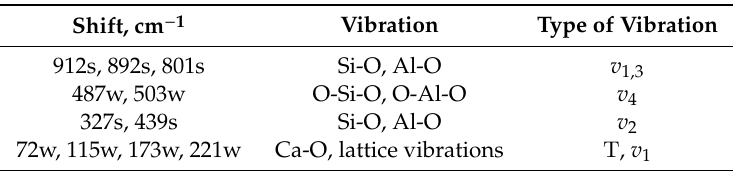
Ca-O, lattice vibrations Т , v